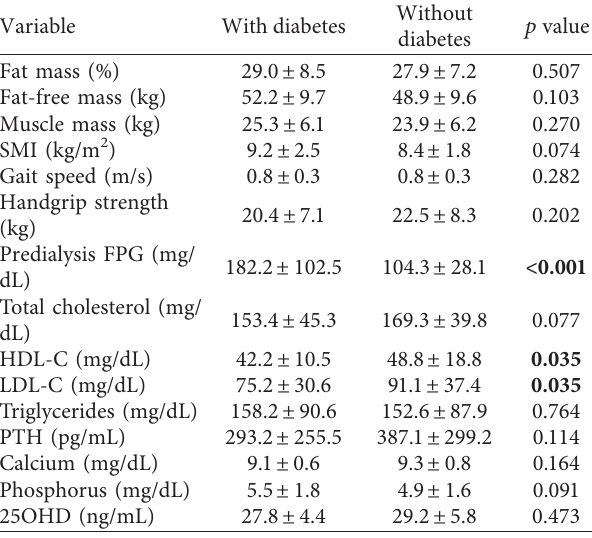
Table 2: Body composition and laboratory